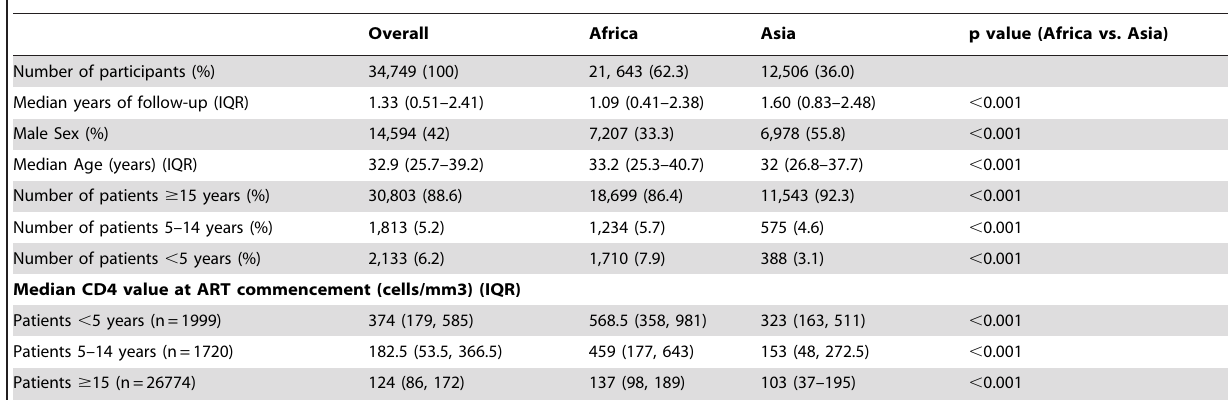
Table 1. Characteristics of study